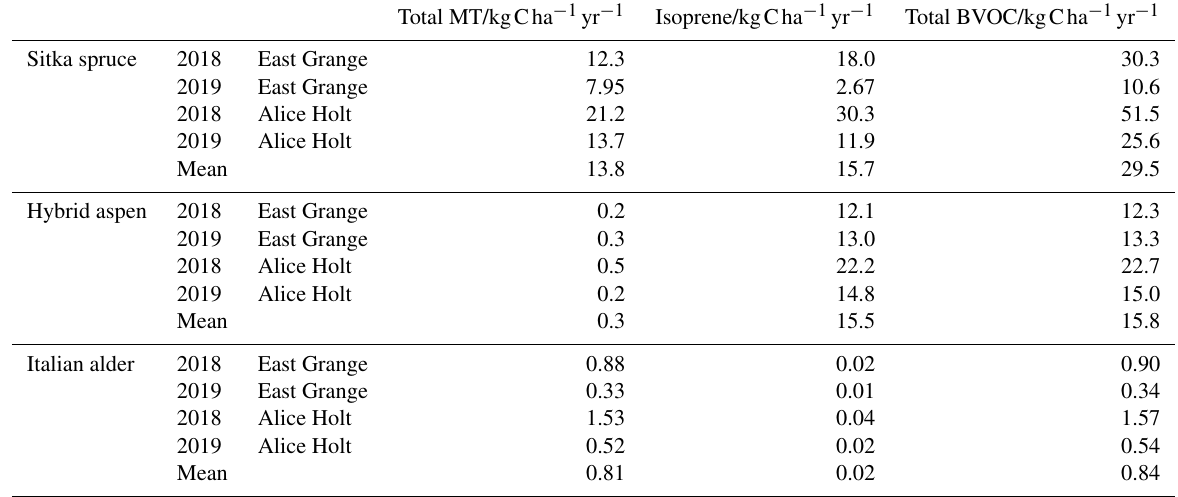
Table 6. Modelled annual isoprene, total monoterpene and total BVOC emissions per hectare of SRF Sitka spruce, hybrid aspen and Italian alder plantations, using meteorology data from two locations, East Grange in east Scotland, and Alice Holt in south-east